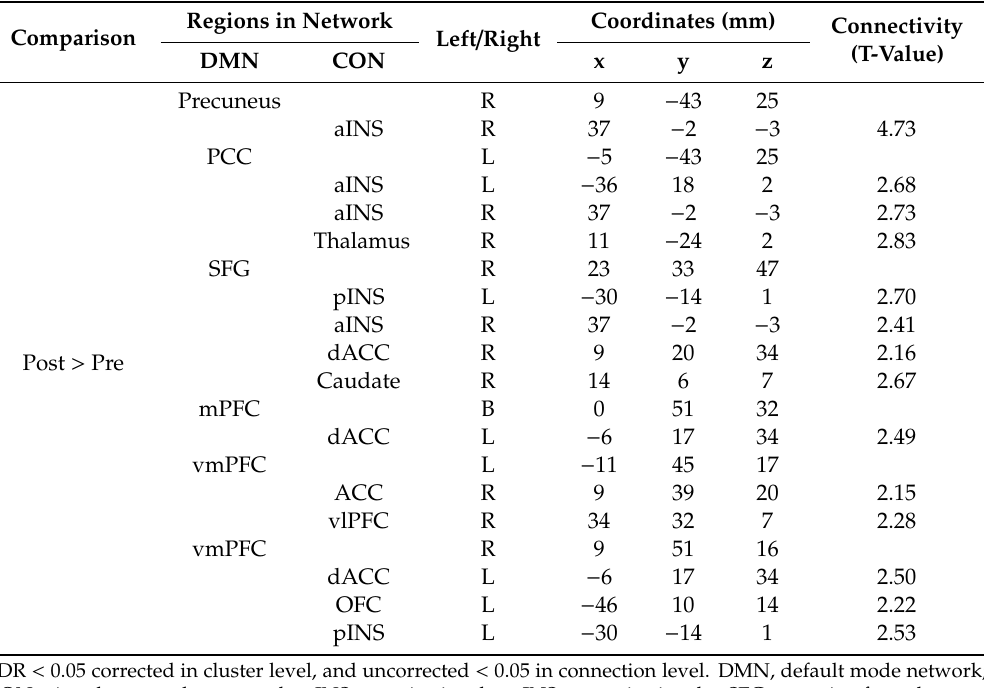
Table 2. The functional connectivity between ROIs for a paired t -test in participants with mild cognitive impairment (MCI) (post-Comcog–pre-Comcog condition). Comparison